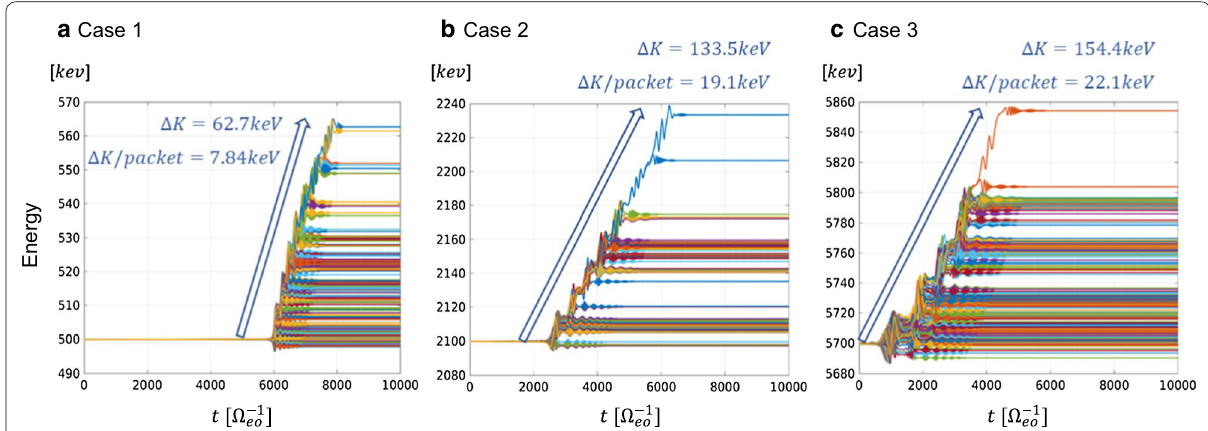
Fig. 9 Temporal energy variations of 360 particles under the initial conditions of case 1 (500 keV-60°), case 2 (2.1 MeV-80°), and case 3 (5.7 MeV-86°). The energy variations of the 360 particles in three cases by the interactions with the chorus wave. The top line reaching the largest energy increase at the termination of the simulation in each case represents the most successful particle discussed in Fig. 7. a The most successful electron in case 1 62.7keV by the interactions with eight wave subpackets. The energy increase per subpacket, therefore, is 7.84 keV assuming gained energy of (cid:31) K = a uniform gradient of the energy increase. b The energy increase of the most successful electron in case 2 is 133.5 keV through interactions with seven subpackets, hence the energy gain per subpacket is calculated as 19.1keV . c Similarly, the energy increase of the most successful electron in case 3 is 154.4 keV through interactions with seven subpackets and the energy gain per subpacket is